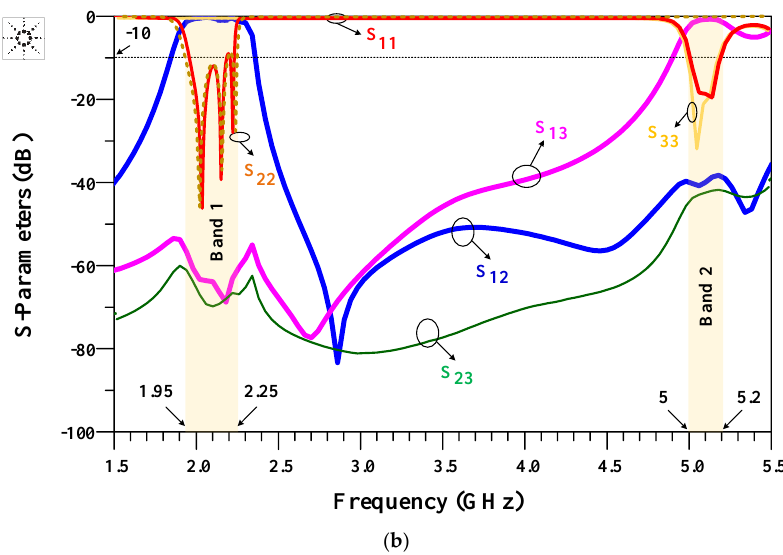
Figure 10. Designed diplexer. ( a ) Circuit structure, and ( b ) S-parameters simulated frequency response (dimensions are in mm). (S 23 ). As shown in Figure 10b, the proposed design has high isolation between output ports at the two pass bands. The isolation levels between two output ports (S 23 ) through the two pass bands are better than 40 dB, which confirm the validity of the analysis. Due to the